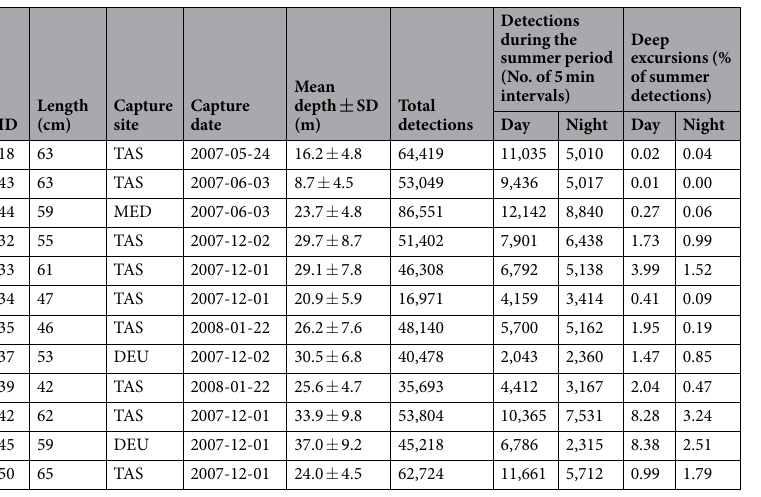
Table 1. Summary of the information and detections of tagged common dentex individuals. Deep excursions refer to the percentage of detections happening below the lower thermocline limit during the summer period (see Methods